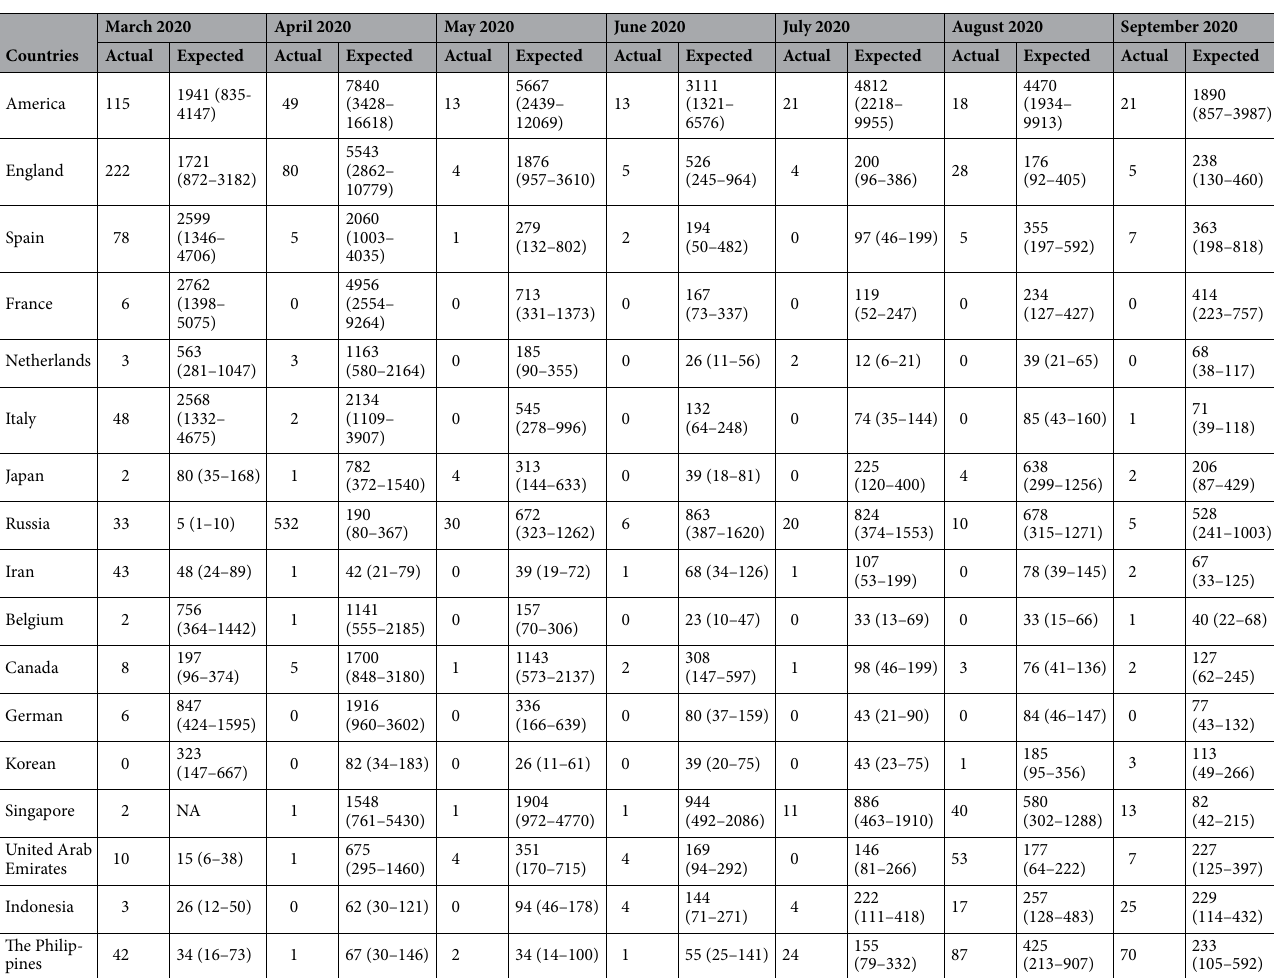
Table 3. Actual and expected imported cases in critical countries from March to September